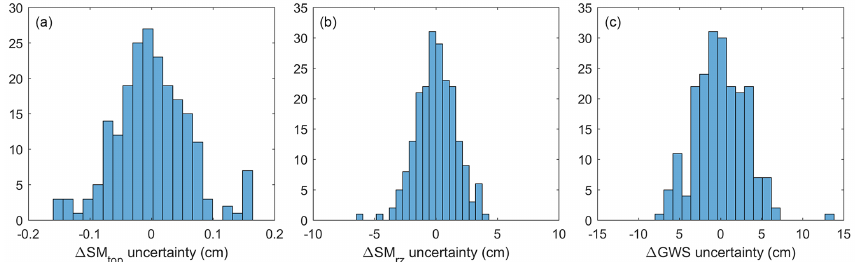
Figure 2. Histograms of the model errors computed from 210 ensemble members ( H (cid:48) all 10 Australian basins) of January 2003, for example, are